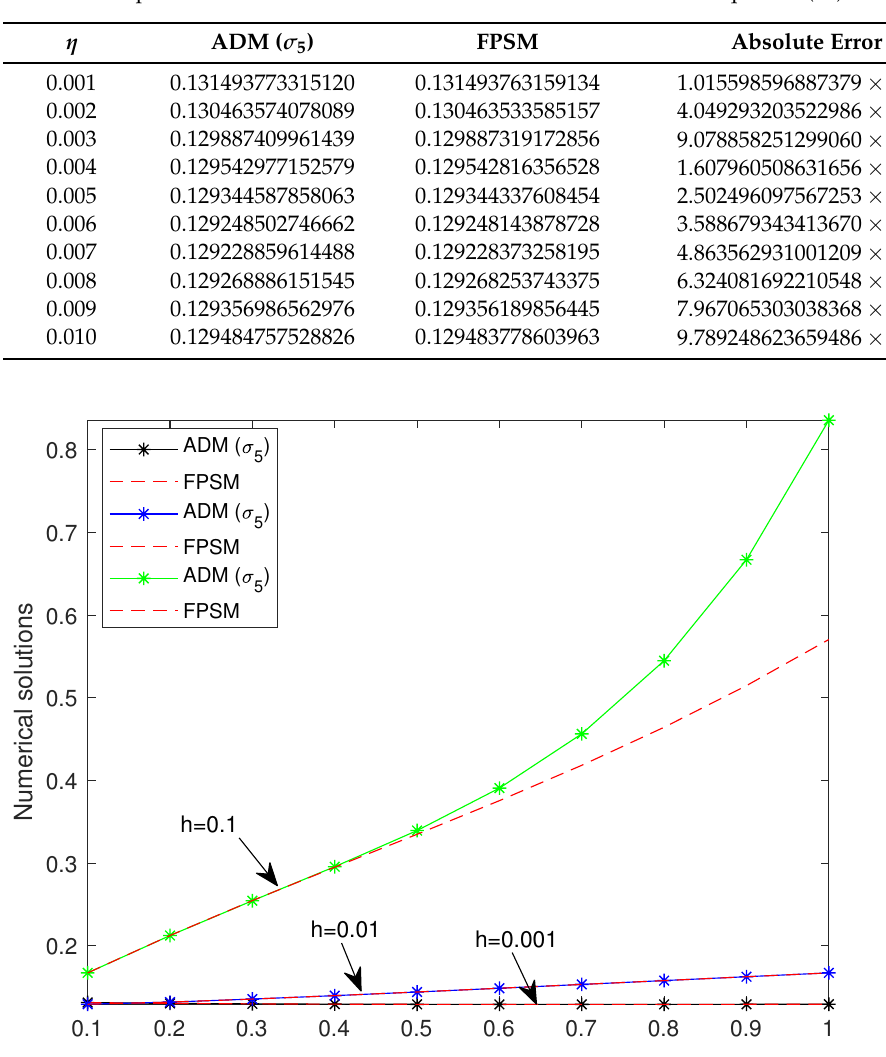
Figure 2. The ADM ( σ 5 ) and FPSM solutions of Equation (33), Υ ( η ) vs η , for h = { 0.1,0.01,0.001 }